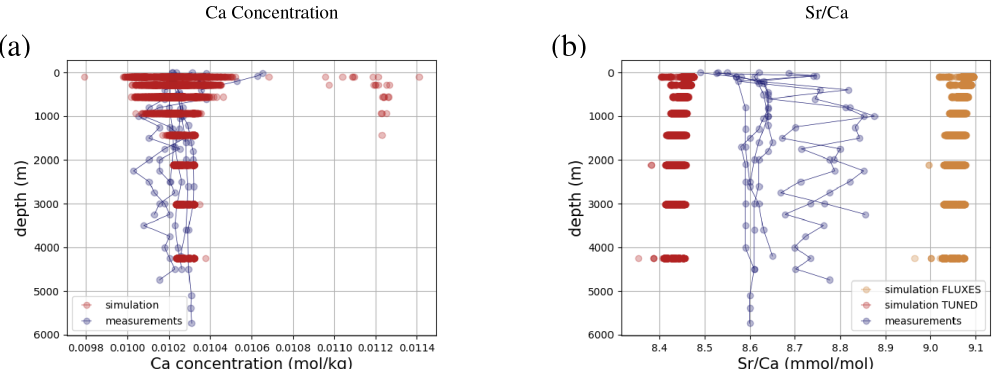
Figure F8. Comparison between measured and simulated Ca (a) and Sr / Ca (b) profiles in seawater. Composites of all available measured concentration profiles and all profiles in the simulation are shown. Data are taken from Fabricand et al. (1967), De Villiers (1999), and Fantle and Tipper (2014). Ca concentrations are normalized to a salinity of